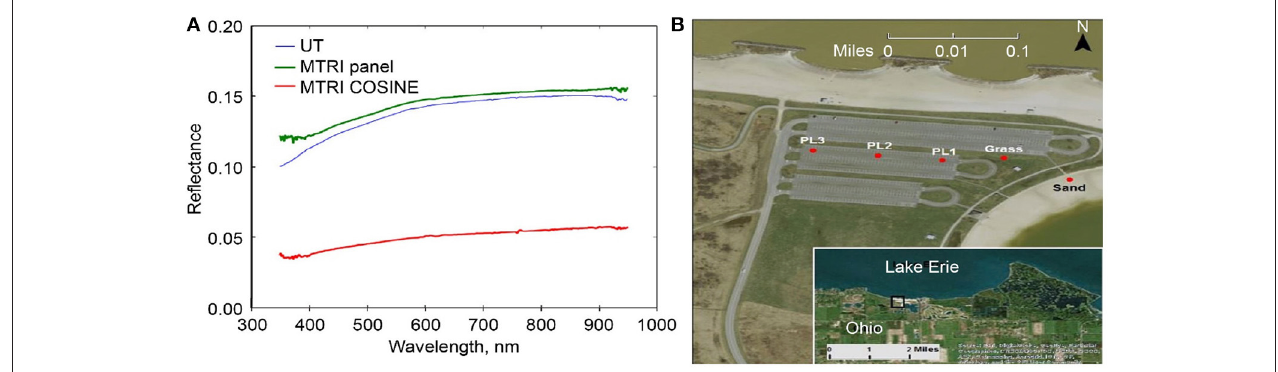
FIGURE 4 | (A) Maumee Bay State Park (MBSP) parking lot blacktop spectral response, as measured by MTRI and the University of Toledo (UT) research teams. (B) NASA Glenn, second generation Hyperspectral imager (HSI2) image of MBSP parking lot in relation to Lake Erie (insert) (After Figures 4.2 and 4.3, Lekki et al.,